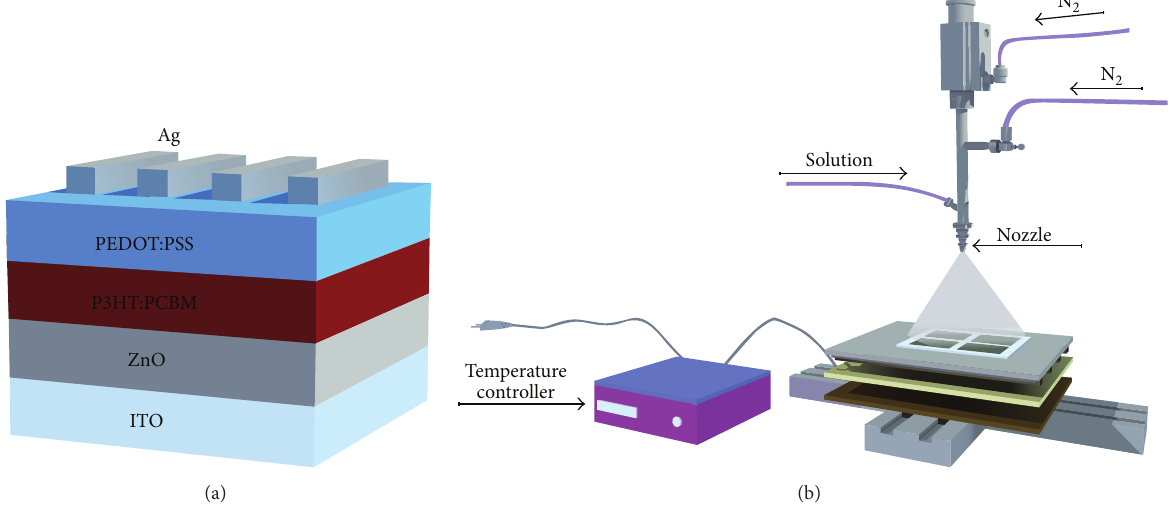
Figure 1: The deposition temperature and thickness of each functional layer in PSCs. (a) The typical device architecture of inverted PSC and (b) schematic diagram of spray-coating